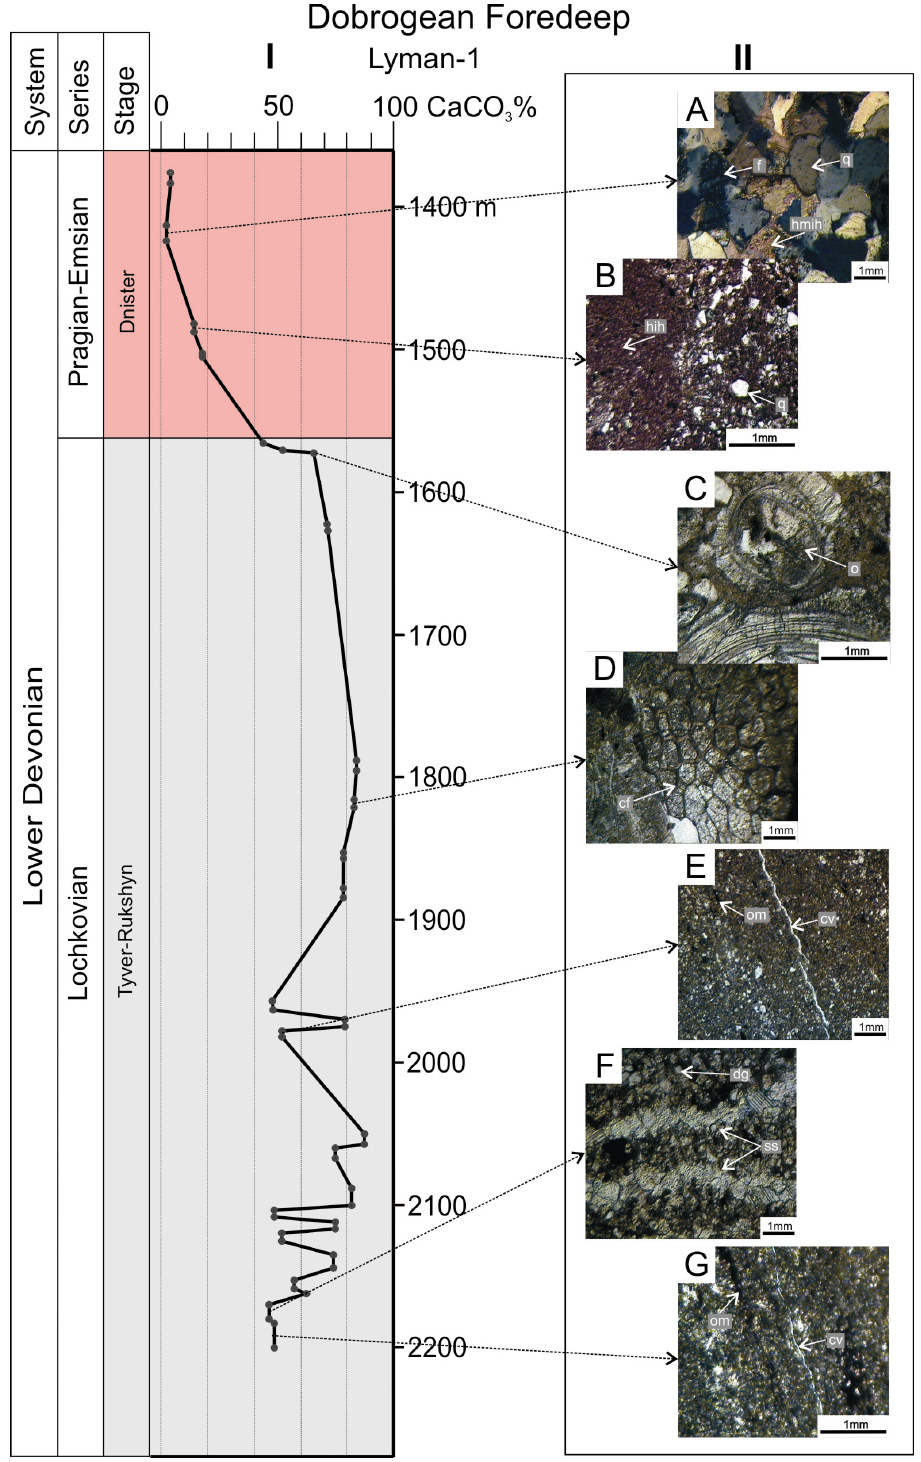
Fig. 4. ( I ) CaCO 3 content in the Lower Devonian sequence of the Lyman-1 borehole (Dobrogean Foredeep). ( II ) Photomicrograph of the Lower Devonian rock of the Lyman-1 borehole (Dobrogean Foredeep). Photomicrograph A was made without analyser, all the rest – with analyser. A, sandstones with hydromica matrix saturated with iron hydroxide (hmih), quartz (q) and feldspar (f), depth interval 1406–1412 m; B, mudstones, composed of hydromica saturated with iron hydroxide (hih) and quartz (q), depth interval 1479–1481 m; C, D, biodetrital limestones: C – ostracods (o), depth interval 1565–1571 m, D – coral fragment (cf), depth interval 1816–1821 m; F – dolomitized limestones with stylolitic sutures (ss) and dolomite grains (dg), depth interval 2170–2180 m; E, G – marlstones with calcite veinlet (cv) and pyritized streaks of organic matter (om): E – depth interval 1979–1981 m, G – depth interval 2180–2200